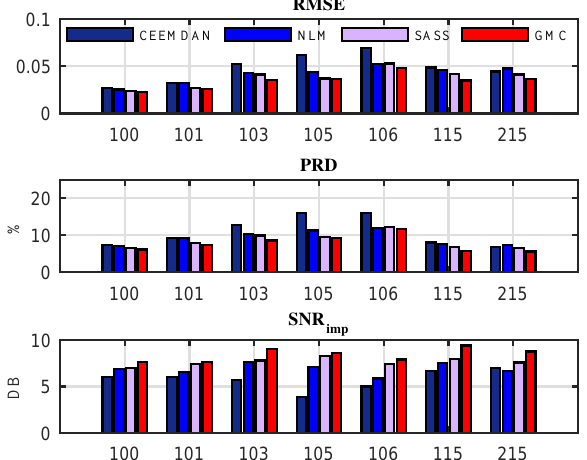
Figure 12. Performance evaluation over RMSE, PRD and SNR imp criteria for different data